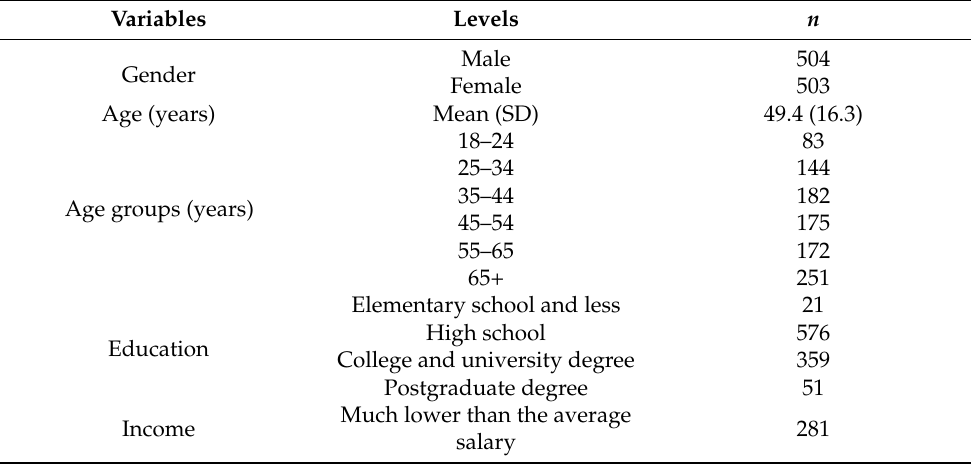
Table 1. Sociodemographic Characteristics of the Study Sample ( n = 1007).